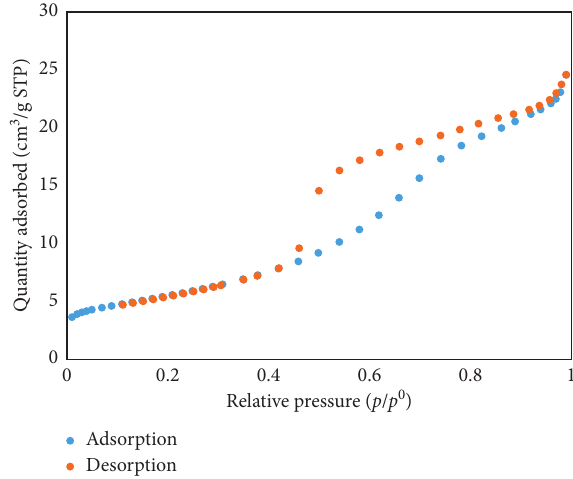
Figure 7: Nitrogen adsorption-desorption isotherms for the C, N- TiO 2